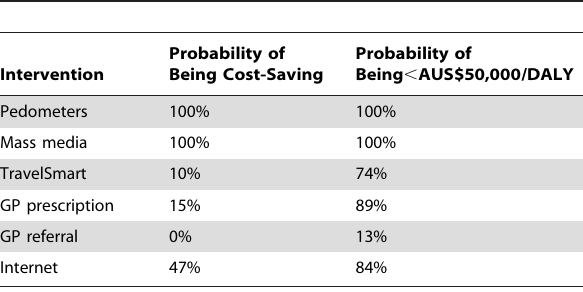
Table 4. Acceptability of physical activity interventions when compared with current